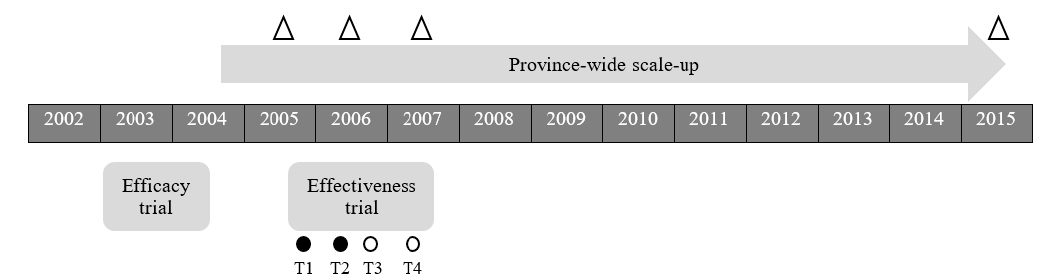
Figure 1. Timeline of Action Schools! BC (AS! BC) scale-up and the randomized controlled effectiveness trial. Open triangles indicate dates where we report implementation strategies and scale-up data (end of first, second, third and final year of scale-up; objective 1). Circles indicate the start of each data collection period within the randomized controlled effectiveness trial (objectives 2 and 3); closed circles represent the beginning (T1) and end (T2) of year 1, open circles represent the beginning (T3) and end (T4) of year 2.